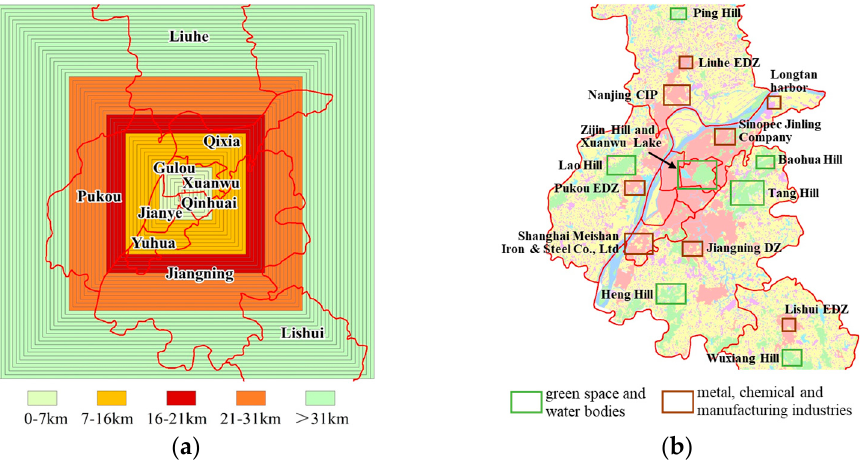
Figure 10. Maps of spatial zoning of Nanjing. ( a ) Spatial zoning of layers; ( b ) Ecological and industrial